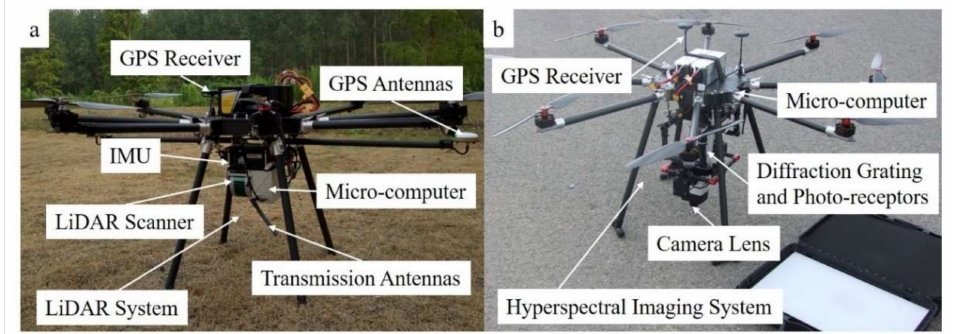
Figure 3. The UAV-LiDAR and UAV-hyperspectral systems used in the study. ( a ): UAV platform with LiDAR system; ( b ): UAV platform with hyperspectral system. Table 1. Summary of flight parameters and UAV-LiDAR and UAV-hyperspectral sensor properties.